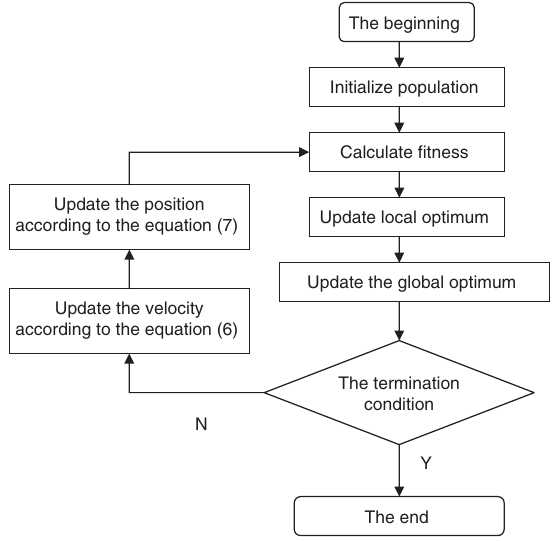
Figure 1: The Flowchart of Particle Swarm